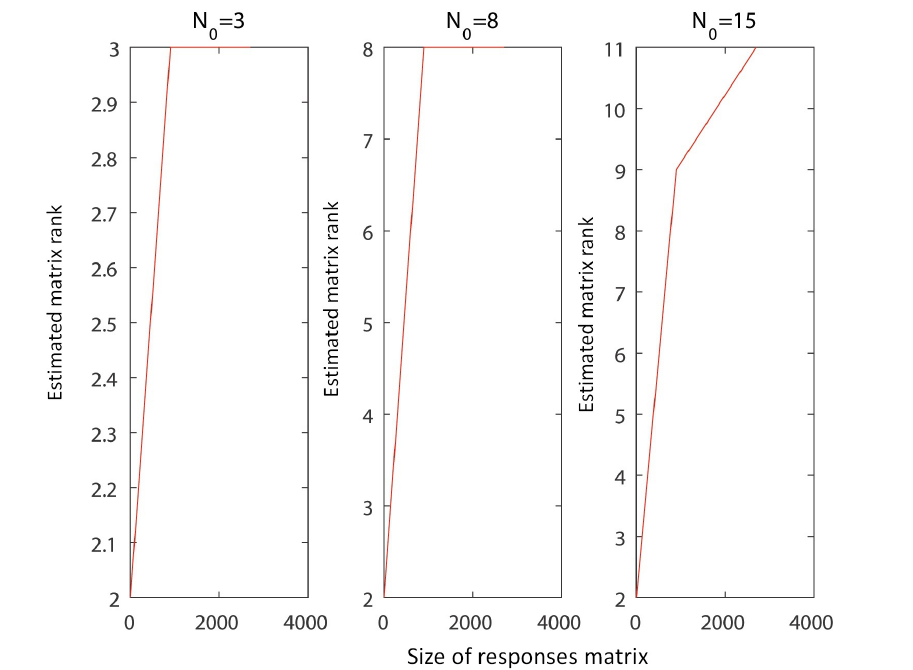
Figure 7. The rank of the responses matrices as a function of the responses matrix dimensions, for the case of Equation 6, where f 0 [ n ] = e − n and the upper limit of the sum N 0 varies. The values of N 0 are shown above the